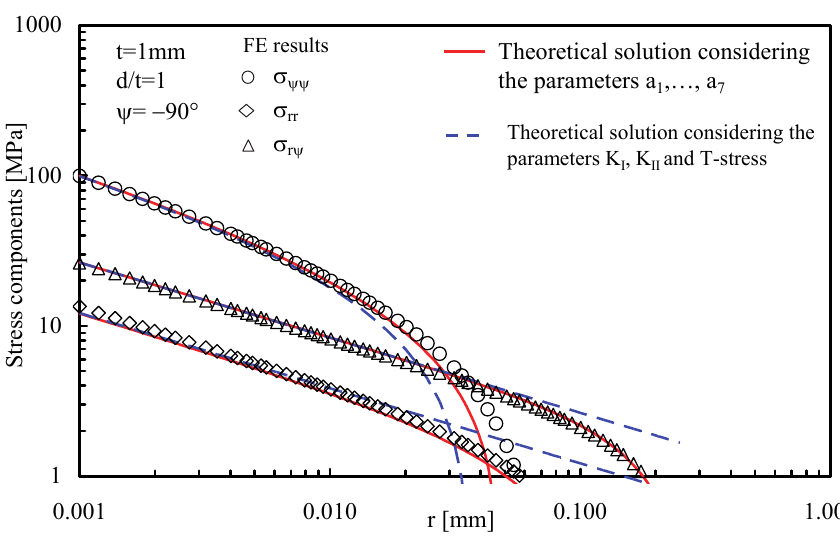
Figure 4: Stress field along the direction  =-90° for the case d/t=1.